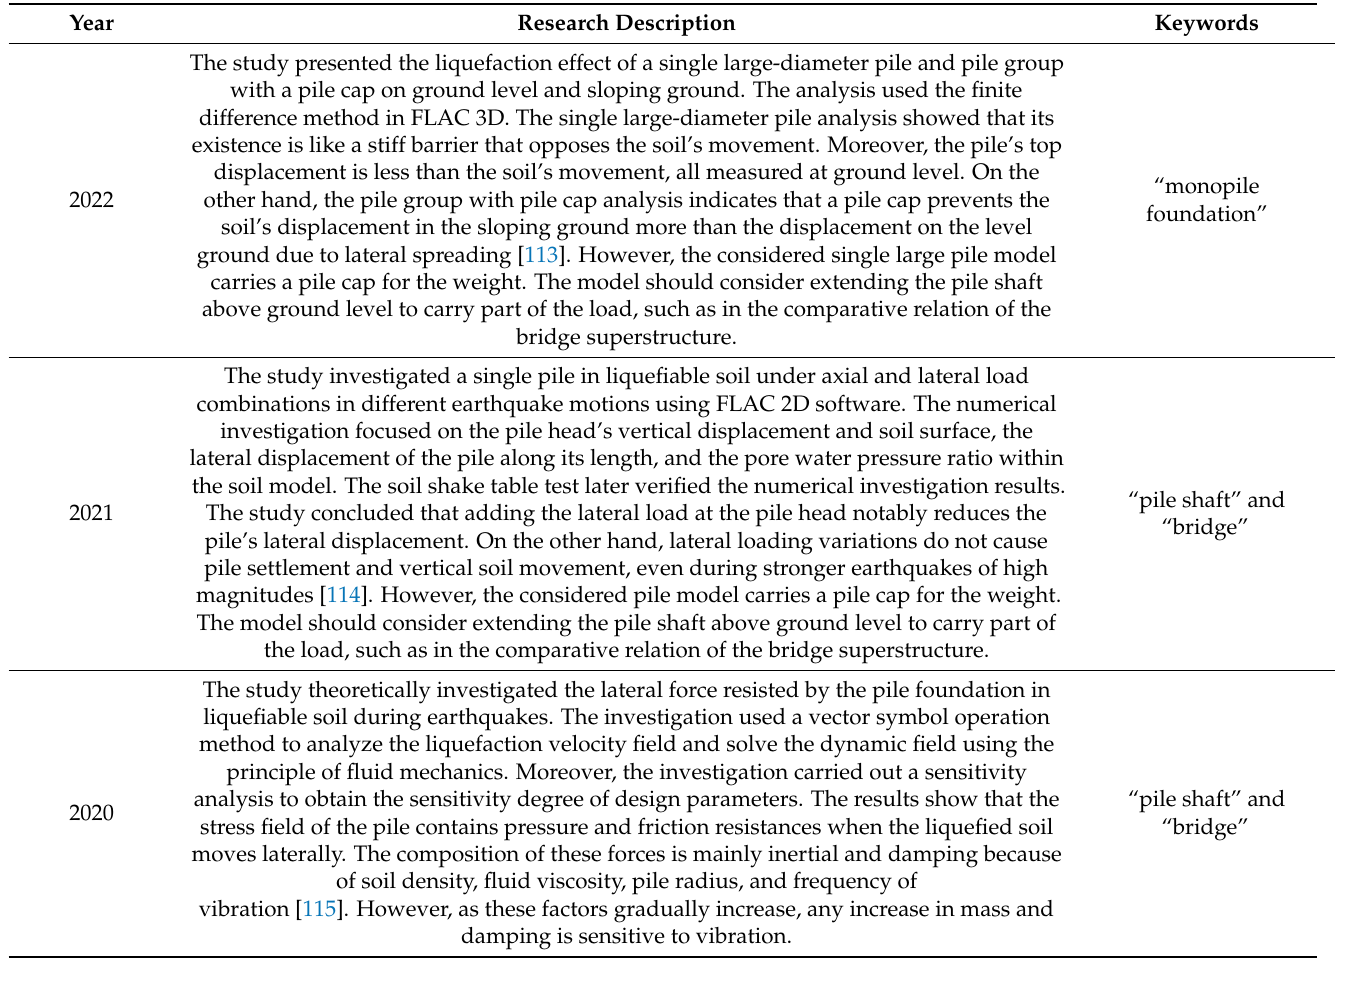
Table 8. Extraction of information from latest studies on monopile